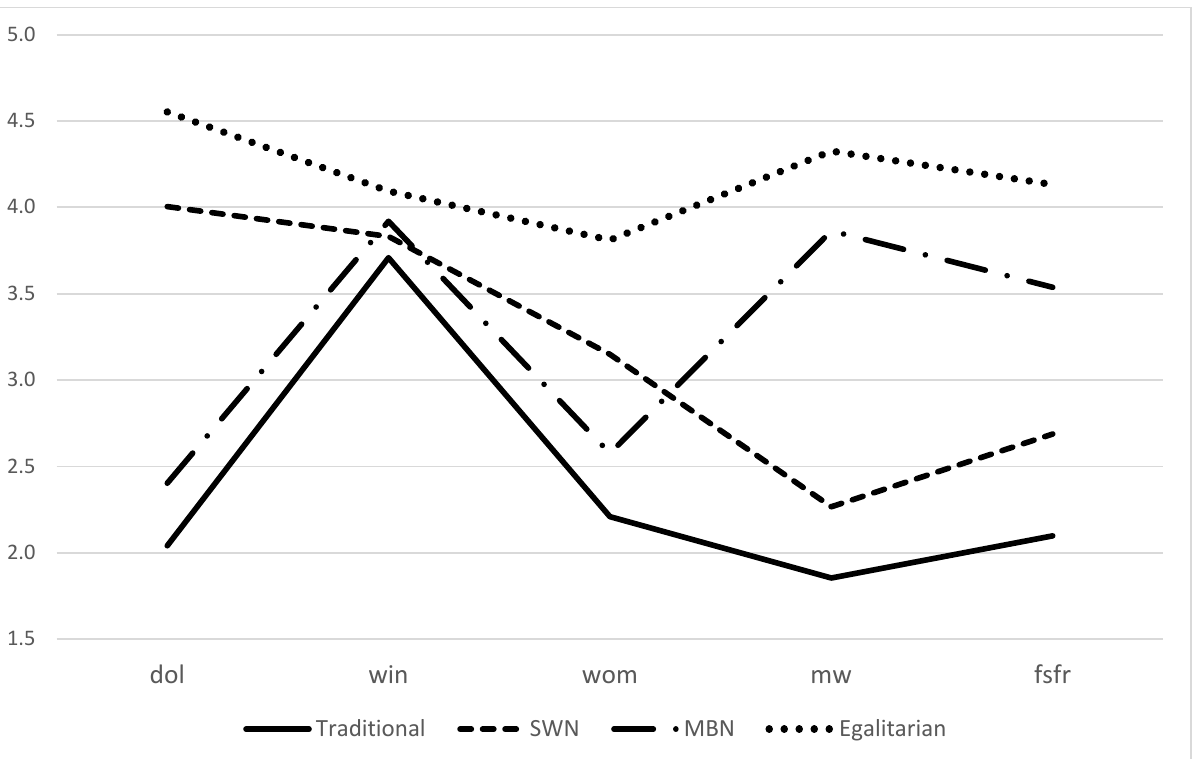
Figure 2. Predicted means of five attitude questions among four types of gender role norms: latent class analysis. dol: a man’s job is to earn money, and a woman’s job is to look after the home and family (5 = strongly disagree); win: both the man and woman should contribute to the household income (5 = strongly agree); wom: a job is all right, but what most women really want is a home and children (5 = strongly disagree); mw: a pre-school child is likely to suffer if his or her mother works (5 = strongly disagree); fsfr: all in all, family life suffers when the woman has a full-time job (5 = strongly disagree).